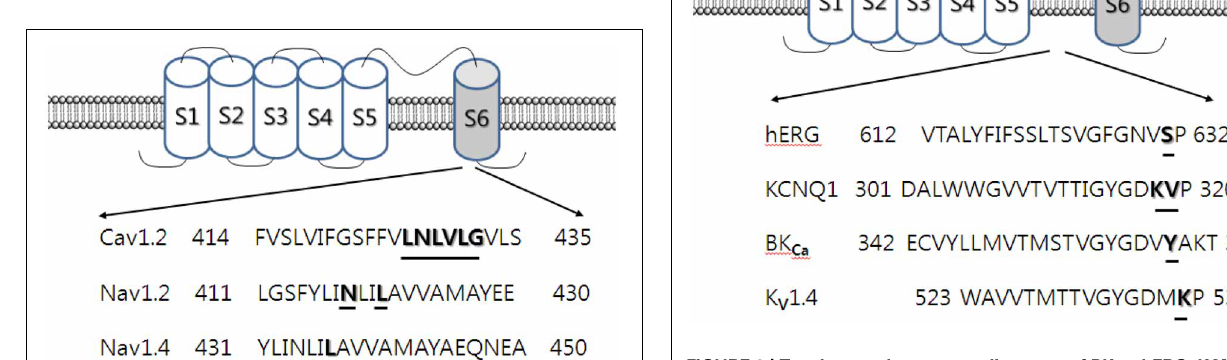
FIGURE 3 | Topology and sequence alignment of BK Ca , hERG, KCNQ1, and Kv1.4 K + channels. BK Ca , hERG, KCNQ1, and Kv1.4 K + consist of the main α subunit and auxiliary β subunits. Tetramer of α subunit forms a functional K + channel. α subunit contains 6 segments. Each segment 4 plays a membrane voltage sensor and segments 5 and 6 form channel pore. The mutated amino acid residues are underlined in the pore-forming segment 5 and 6. The underlined specific amino acid residues in those K + channels are thought to interact with 20( S )-ginsenoside Rg 3 near the K + channel “signature sequence” of –TXGYGD– (Lee et al., 2008a; Choi et al., 2010,